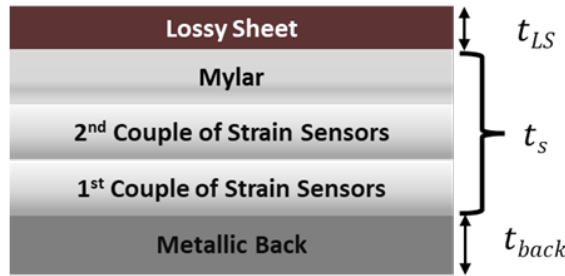
Figure 5. Sketch of the SEAL constituted by the stack of five different layers: the lossy sheet on a mylar substrate (RAS), two mylar layers with sensor strips, and the aluminum back plate.